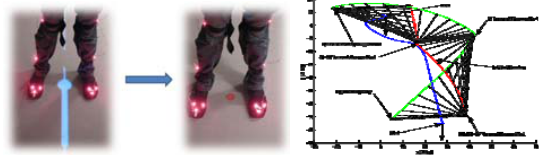
Figure 6. An example of videoprojected start location (left), the end location is constant in space (middle), measured step sequence (right).